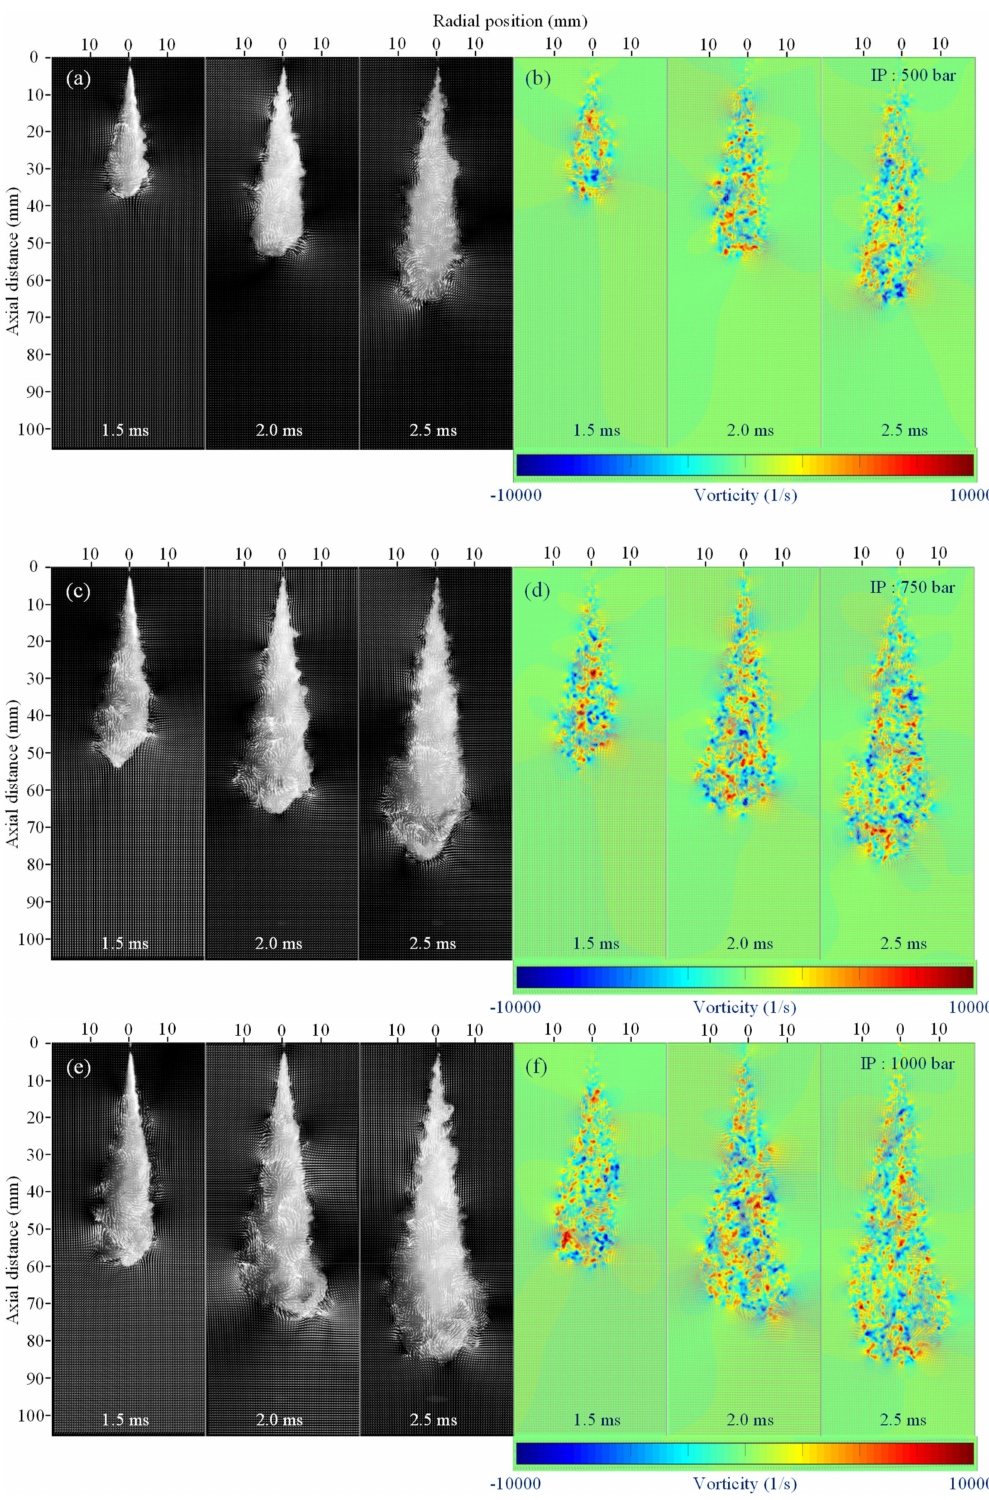
Figure 16. The vector ( a ), ( c ) and ( e ) and vorticity distribution ( b ), ( d ) and ( f ) of GB05 spray under the back pressure of 50 bar with the injection duration of 1000 µ s, and injection pressures of 500, 750 and 1000